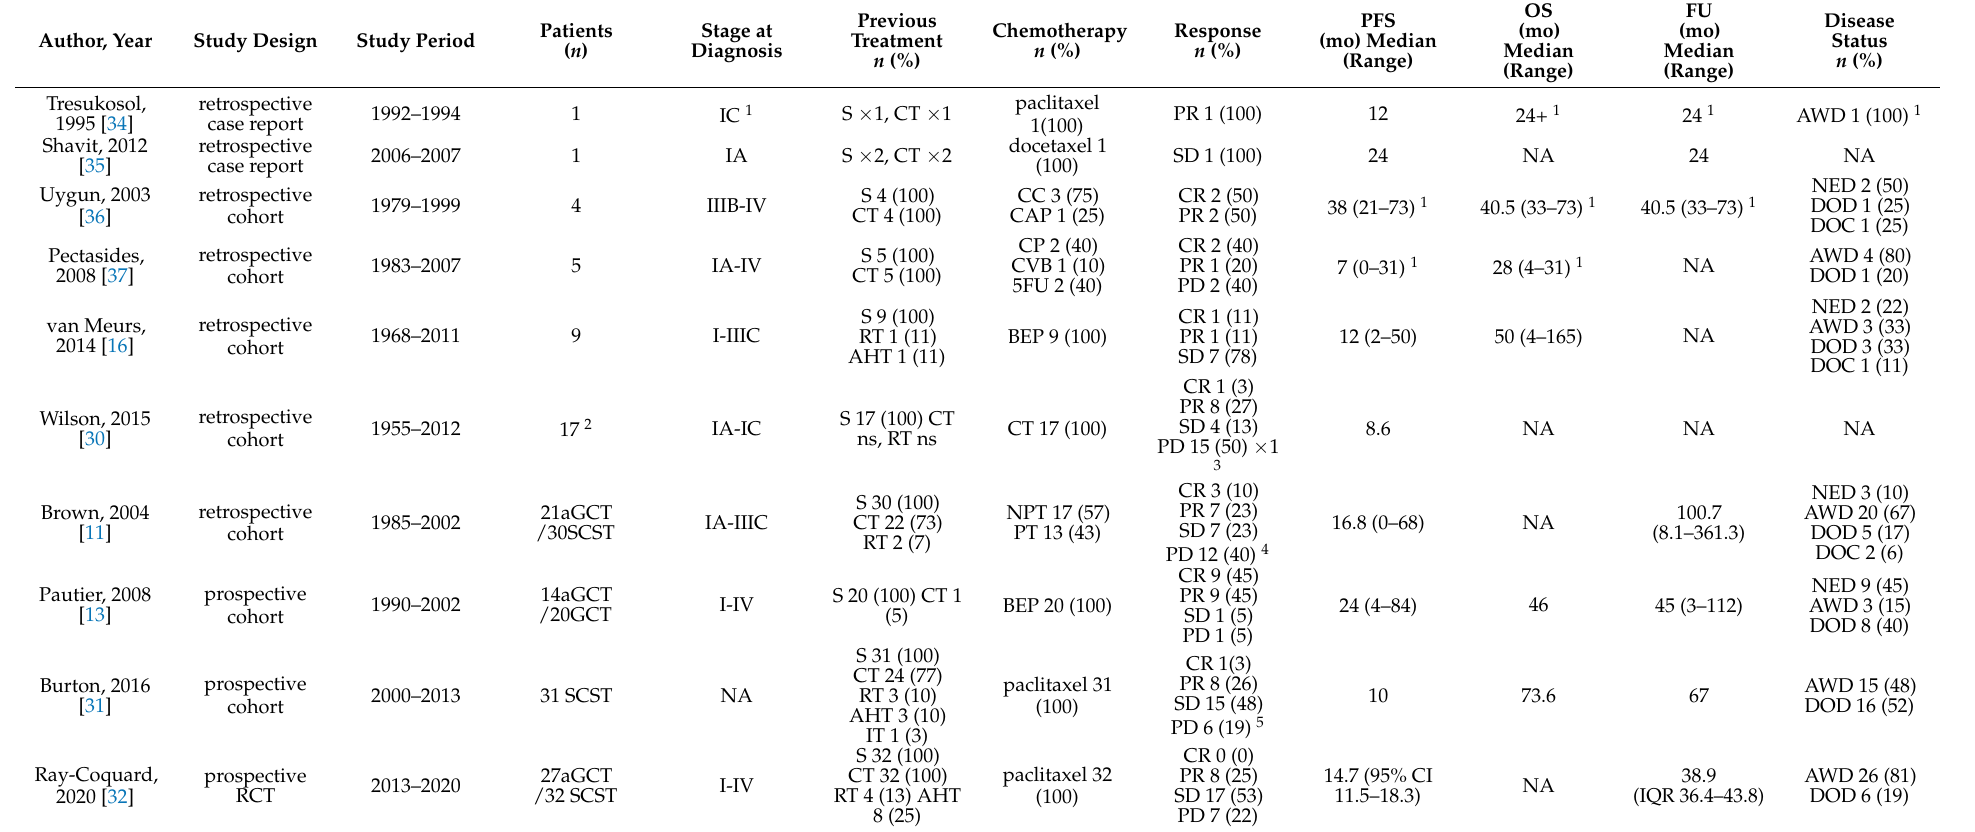
Table 1. Summary of studies describing the use of chemotherapy in